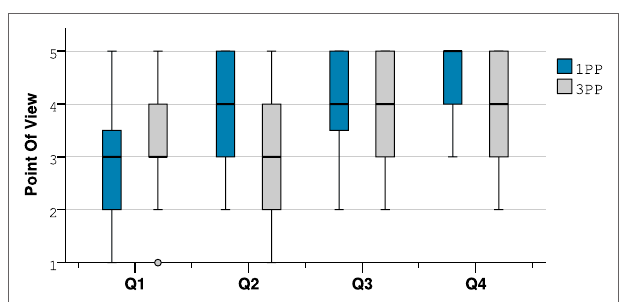
FigUre 12 | Boxplot of the average duration of the interactions with the terminals.